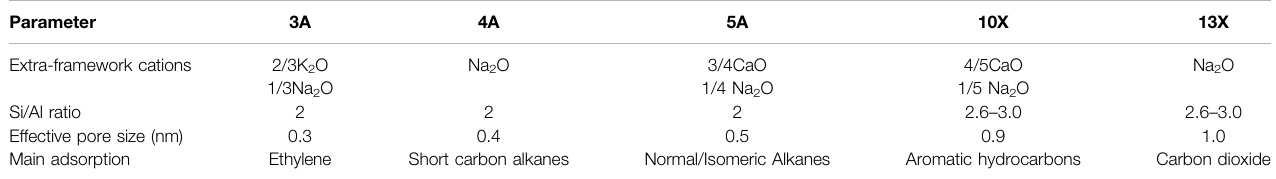
TABLE 4 | Speci fi cations of commonly used molecular sieves.